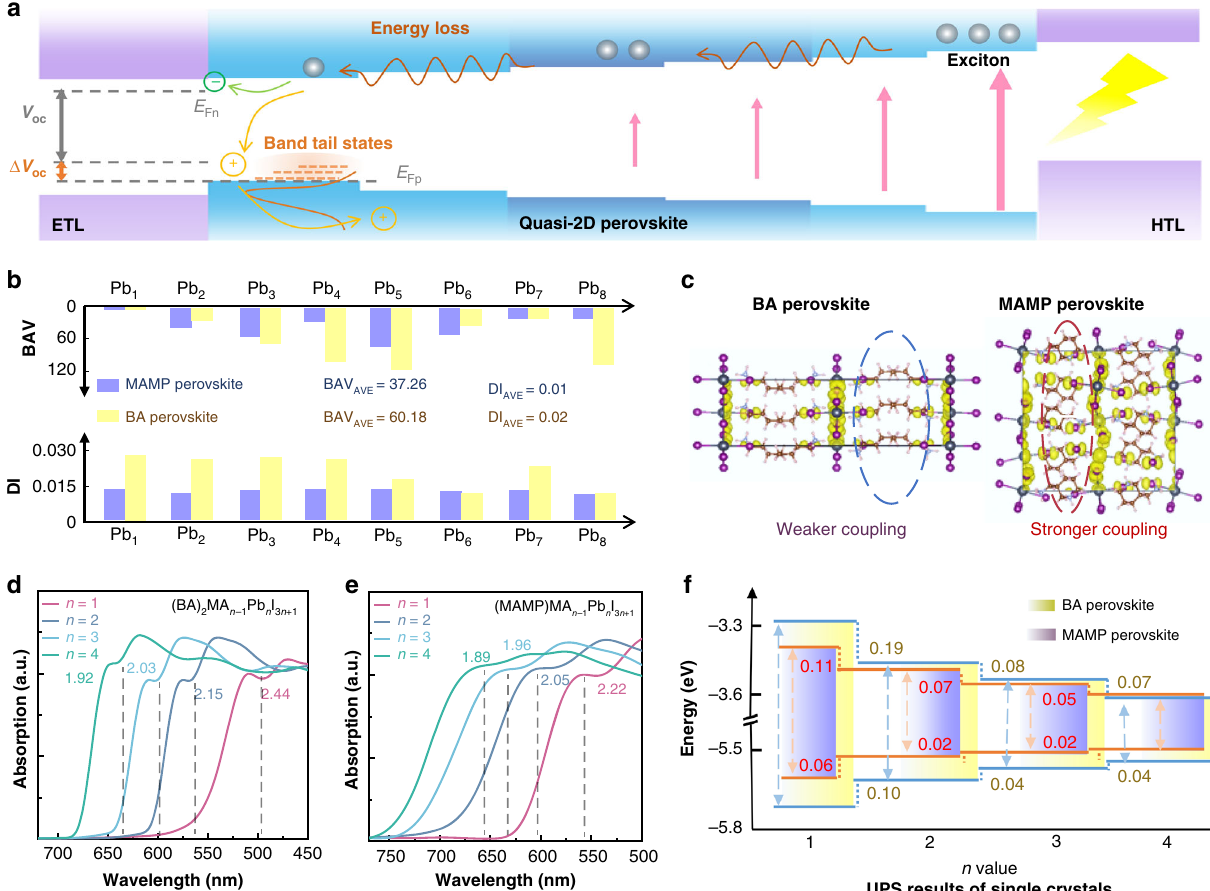
Fig. 1 Device operation mechanism and DFT simulation. a Operation mechanism of quasi-2D perovskite photovoltaics and the correlation between band structure, energy disorder, and V oc of the device. b [PbI 6 ] 4 − octahedron distortion for (BA) 2 (MA) 3 Pb 4 I 13 and (MAMP)(MA) 3 Pb 4 I 13 , and the resulting BAV and DI. c Spinor density for (BA) 2 PbI 4 and (MAMP)PbI 4 perovskites illustrating interlayer I – I interactions. Absorption spectra for d (BA) 2 MA n − 1 Pb n I 3 n + 1 and e